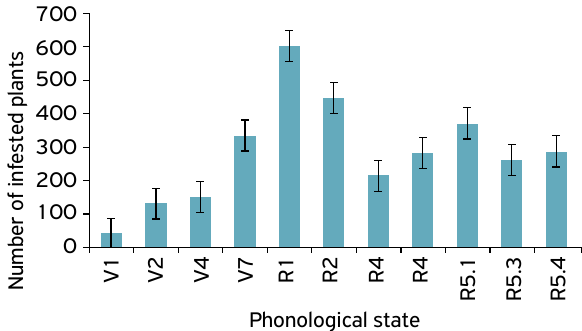
Figure 1. Occurrence and standard error of the mean number of plants infested by the whitefly in the experimental area in the phonological stages of the soybean cultivar Don Mario ® 7.0i. Dourados, MS,